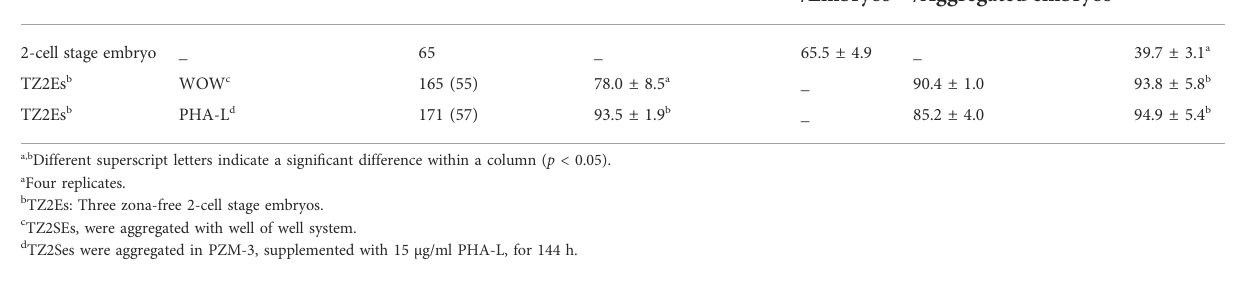
TABLE 4 Effects of Phytohemagglutinin (PHA-L) on the aggregation ef fi ciency and developmental competence of parthenogenetic embryos in pigs. Type of